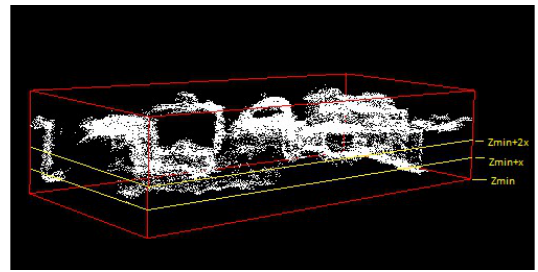
Figure 2: The algorithm searches, starting from the Zmin and for two more iterations, for the lowest level The distance between each search defines the accuracy of the estimation of the surface’s position. At the same time, though, the smaller the step, the more iterations take place, and the slower the performance is. The user is able to define the search step depending on the project’s requirements. When the